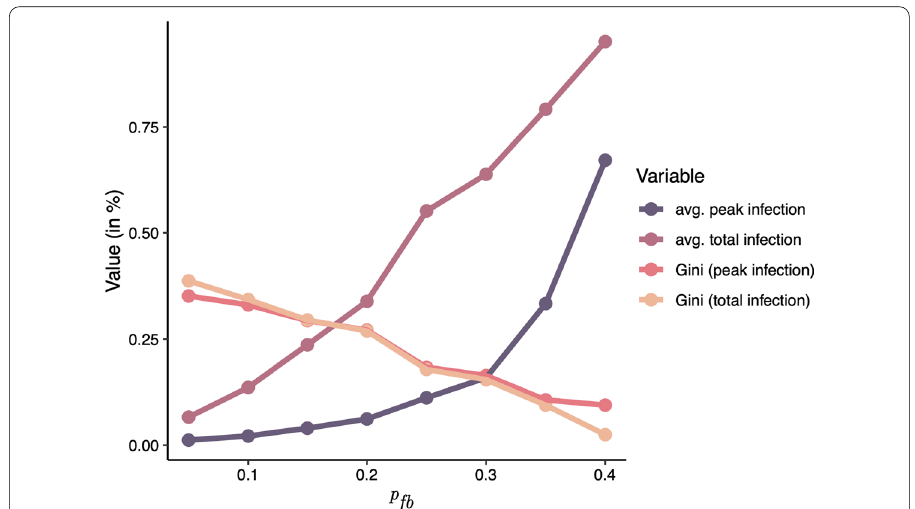
Fig. 6 Average infection and gini coefficient for the two infection measures (peak infection and total infection)